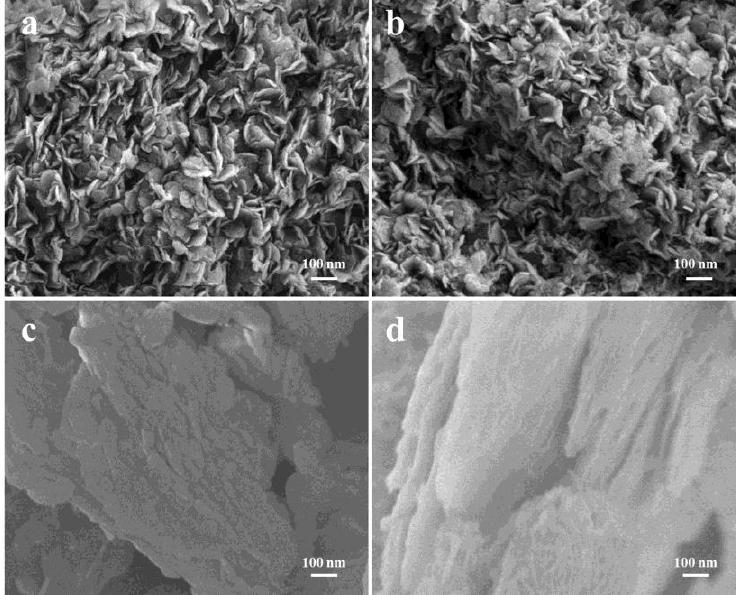
Figure 1. SEM image of ( a ) PTB-LDH3, ( b ) PTB-LDH4, ( c ) PTB-LDO3 and ( d )